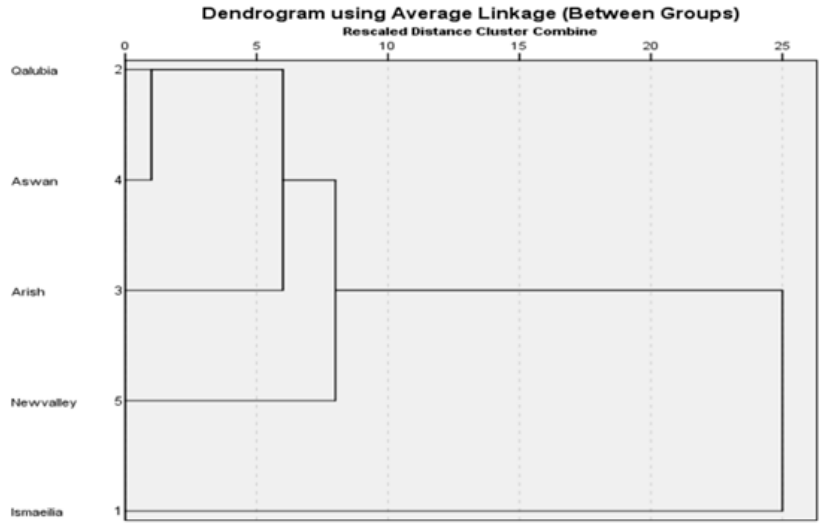
Figure 9. Dendrogram demonstrating the relationships among five R. ferrugineus populations based on data recorded from RAPD and ISSR markers.